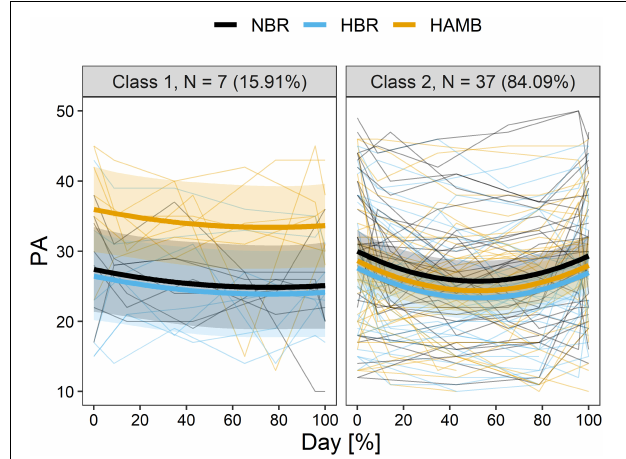
predicted levels as a function of percentage of duration, and the ribbons represent the corresponding 95% CI. Thin lines depict individual